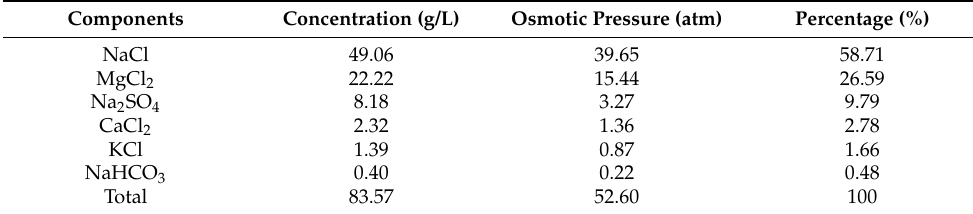
Table 2. The specific components of seawater